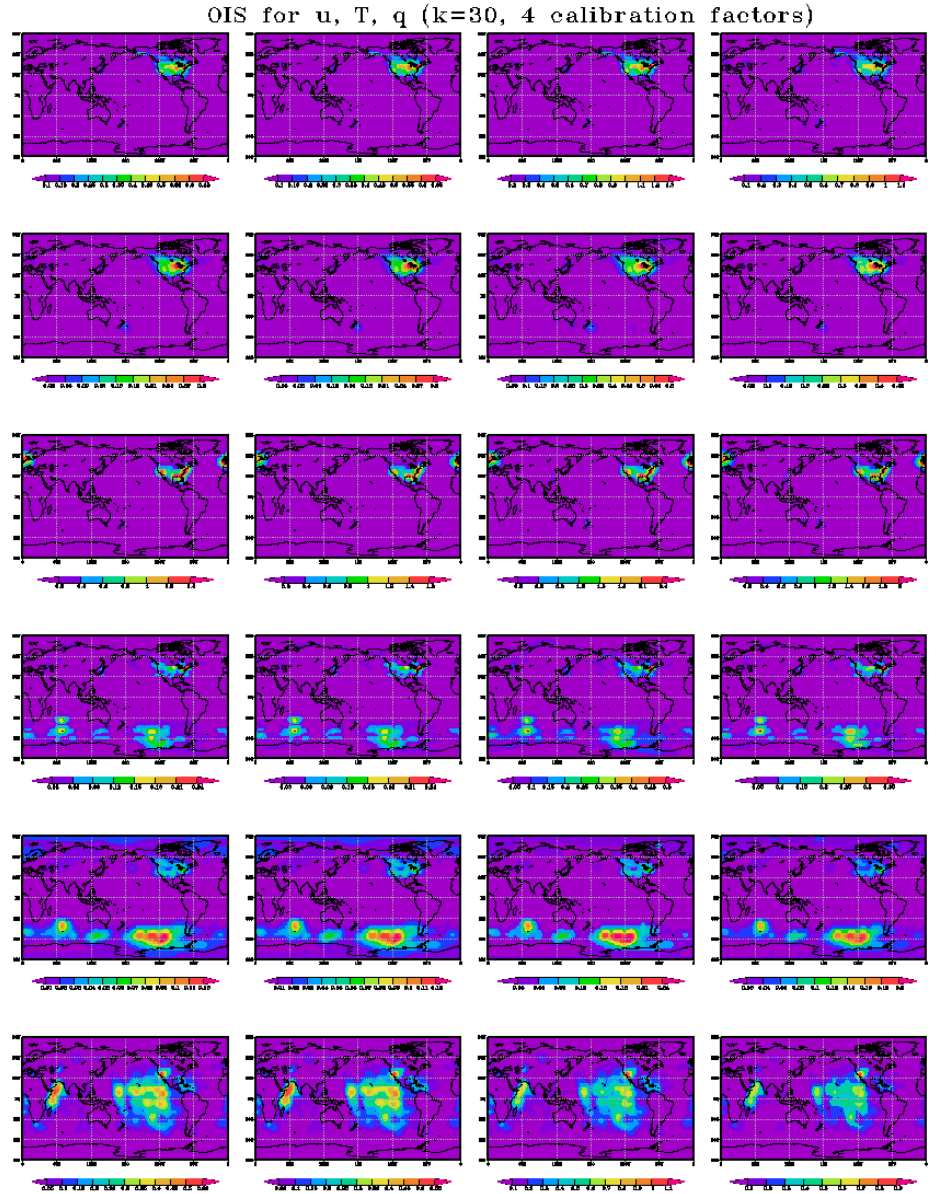
Fig. 8. OIS with four calibration schemes for u 500 ,t 500 , and q 1000 . From the left to the right on each column: OIS values from schemes C 1 ,C 2 ,C 3 , and C 4, respectively. Rows 1 to 3 on each column: for u 500 ,t 500 , and q 1000 with ndat = 6. Rows 4 to 6 on each column: the same variables for ndat =